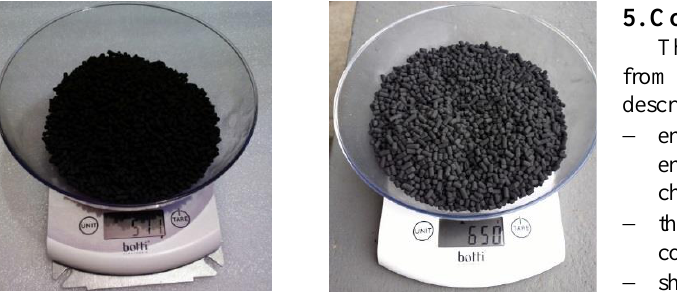
Fig. 8. Weighting of 1 l of activated carbon. Left side – clean carbon – 511 g, right side carbon after 4 months of operation – 650 g